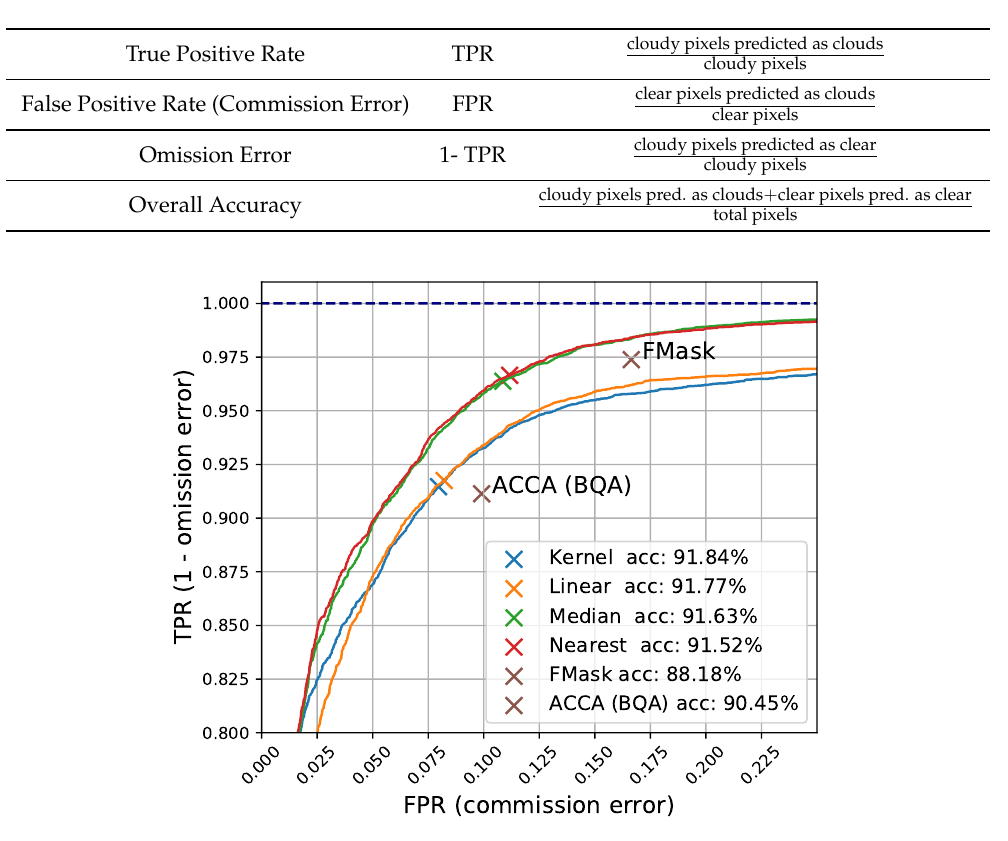
Figure 4. This figure shows ROC curves for the four proposed background estimation methods. Crosses show the TPR and FPR values for the proposed threshold (0.04) and for FMask [5] and ACCA (BQA) [27] on the same